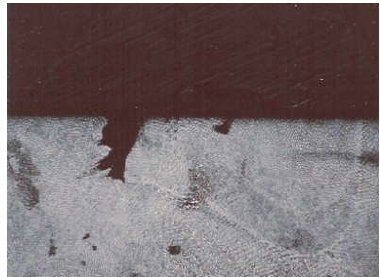
Figure 22. Microelectrode positioned in the weld area, longitudinal surface. Sample #4.